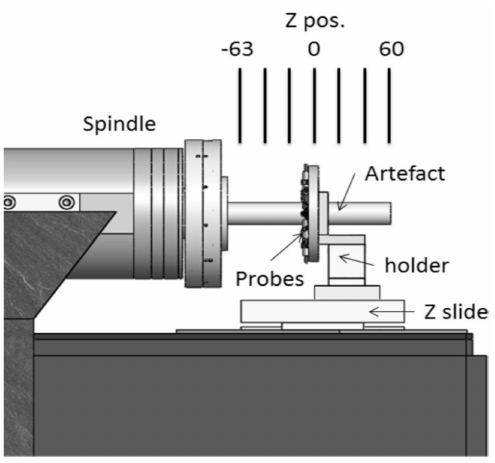
Figure 51. Schematic diagram of the tilt error measurement method [41].